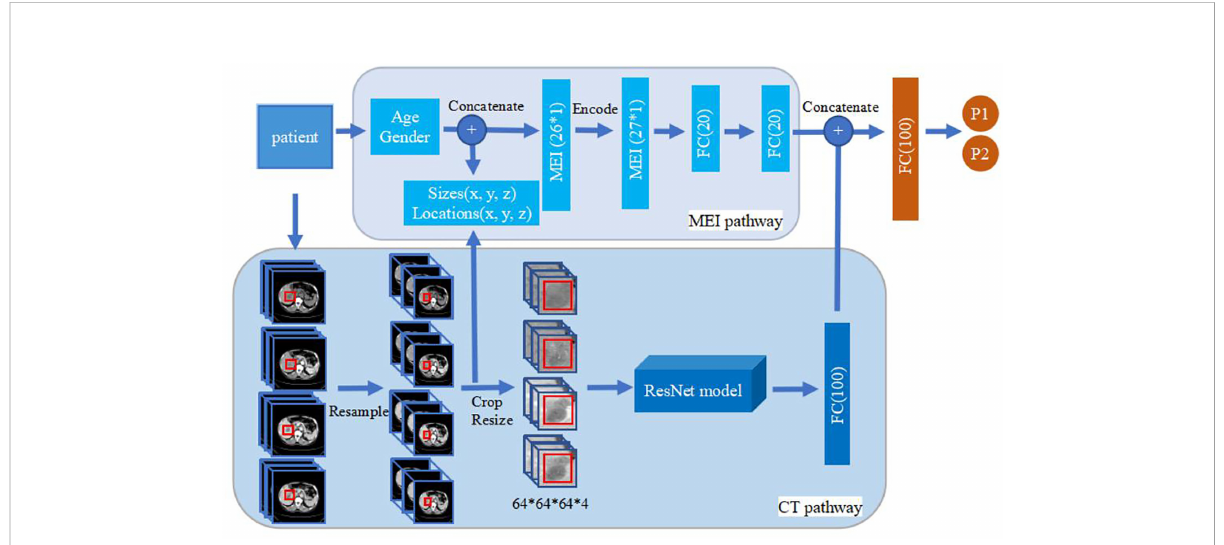
FIGURE 2 Overview of the proposed method. The upper part is MEI pathway and the lower part is the CT pathway. The 3D ResNet in CT pathway contains 14 layers (13 convolution layers, and 1 global average pooling layer). Filter size of the fi rst convolution layer is 5×5×5, and the following fi lter sizes are 3×3×3. Filter size of the global average pooling layer is 2×2×2. The basic model and enhanced model only have the CT pathway. The size of image input in basic model is 64×64×64×1 while the others are 64×64×64×4. MEI, Minimum Extra